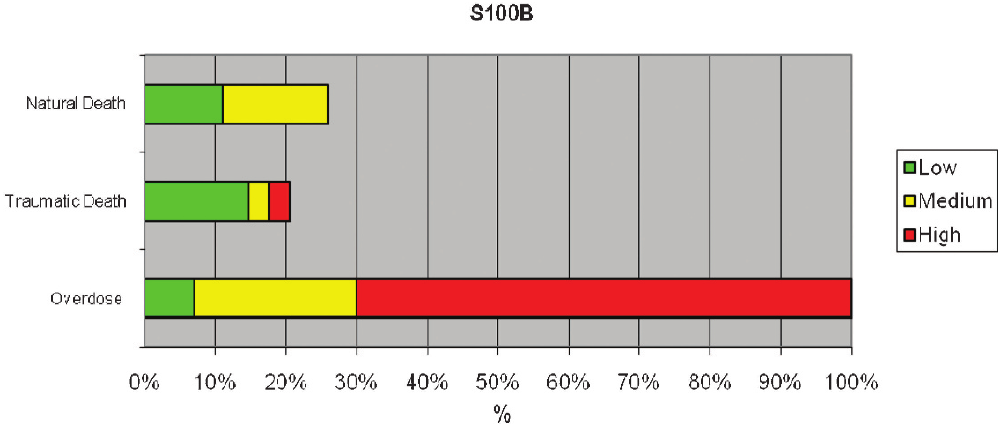
Figure 1 - S100B positivity and cause of death.